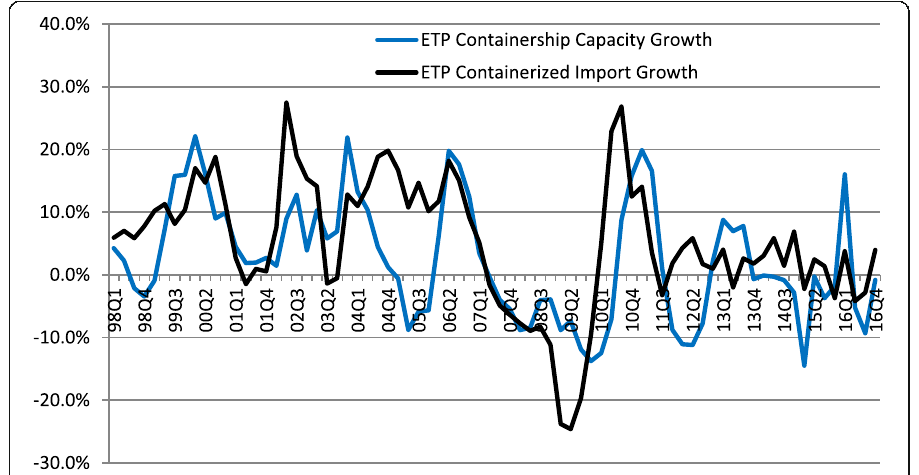
Fig. 3 Eastbound Transpacific QoQ Growth in